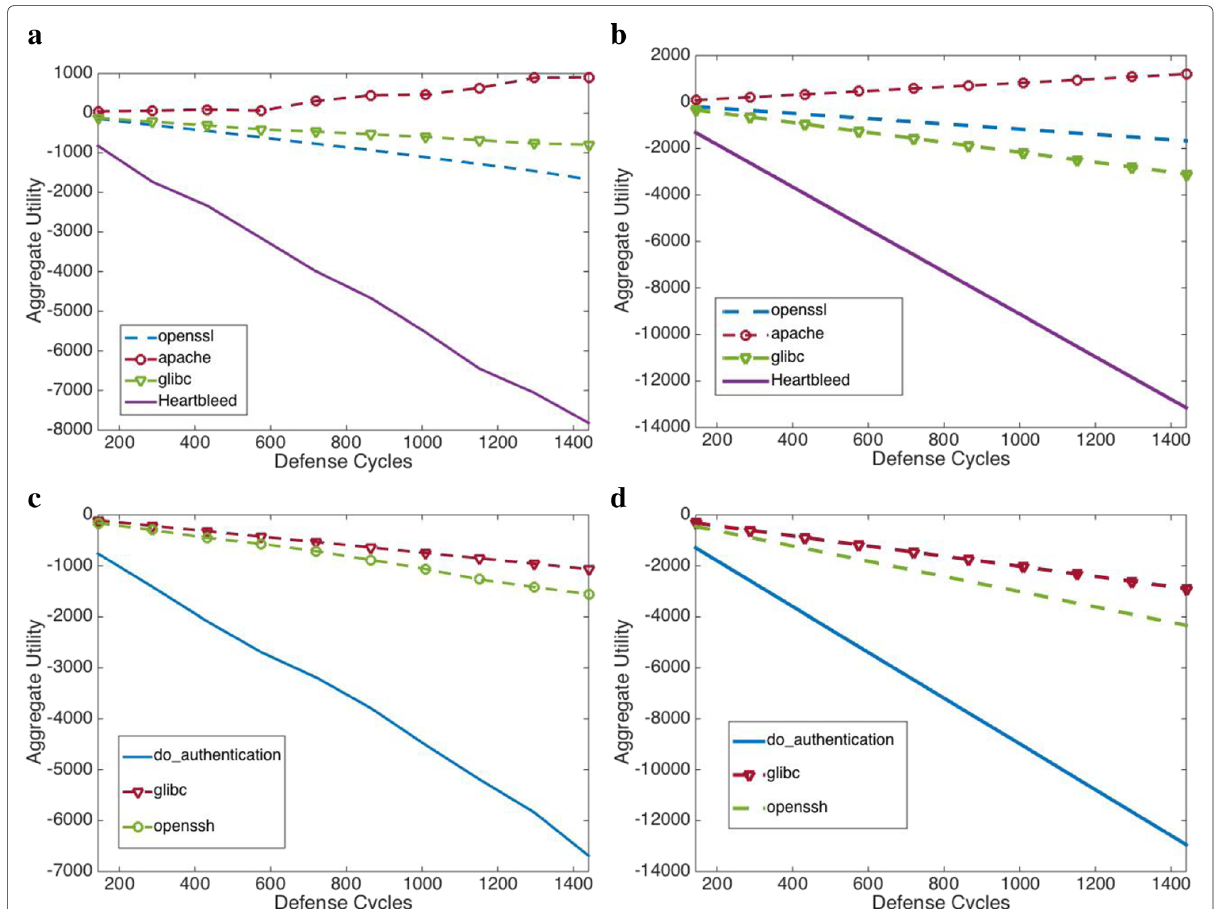
Fig. 4 a - b : Comparisons among the aggregate utility values in Matlab simulations and Apache experiments when defending against openssl (CVE-2002-0656), glibc (CVE-2015-0235), apache (CVE-1999-0071), and Heartbleed (CVE-2014-0610); c - d : the comparison among the aggregate utility values in Matlab simulations and Openssh experiments when defending against glibc (CVE-2015-0235), openssh (CVE-2001-0144), and do_authentication